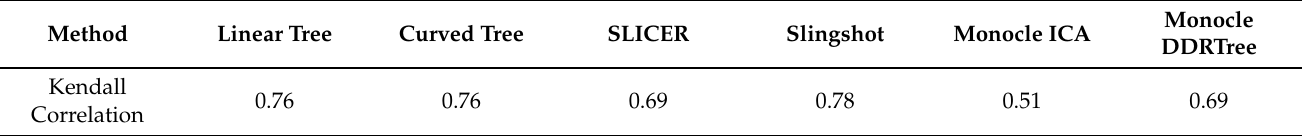
Table 4. Kendall correlation for all methods on the Zygote–Blastocyst